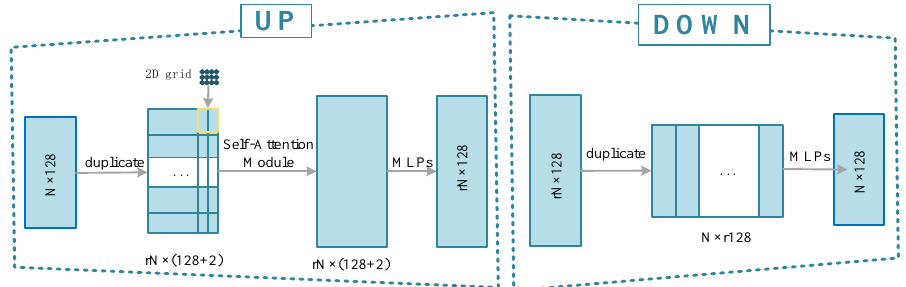
Figure 4. The up module and down module in the generator of MU-GAN.